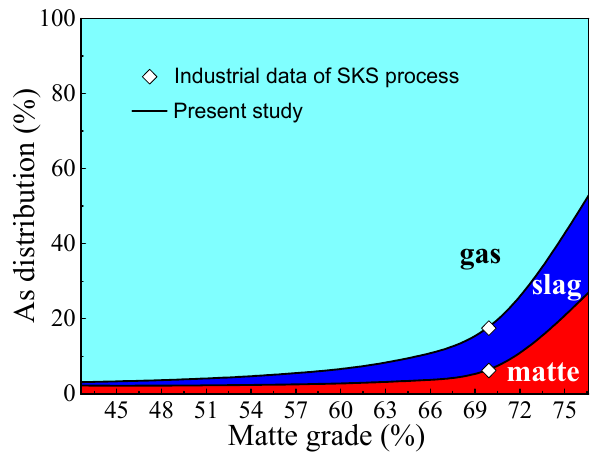
Figure 9. Effects of matte grade on arsenic distribution in SKS process.